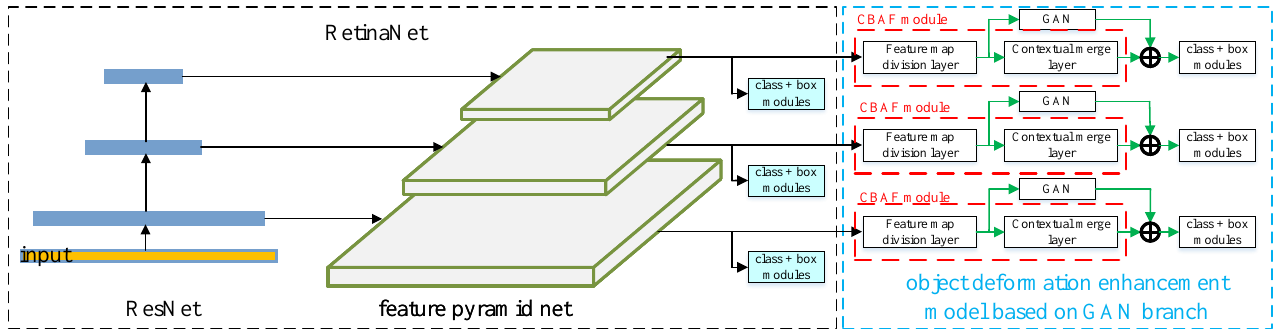
Figure 6. Overview of network